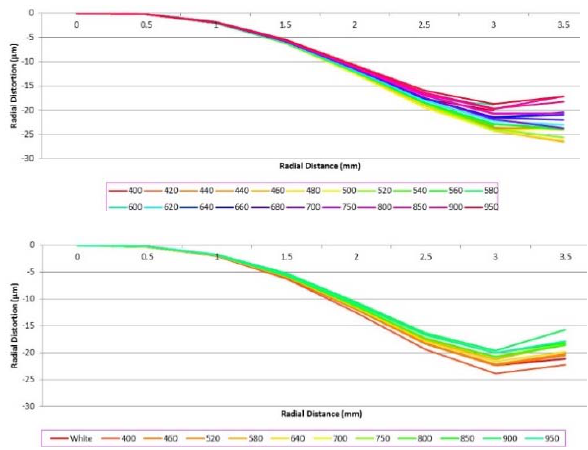
Figure 12. Variation in Radial Distortion with Wavelength.